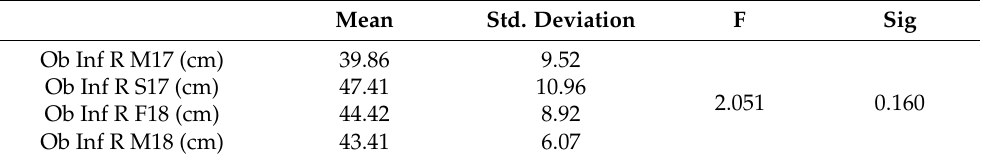
Table 7. OB values in the inferolateral direction of the right arm. Mean Std. Deviation F